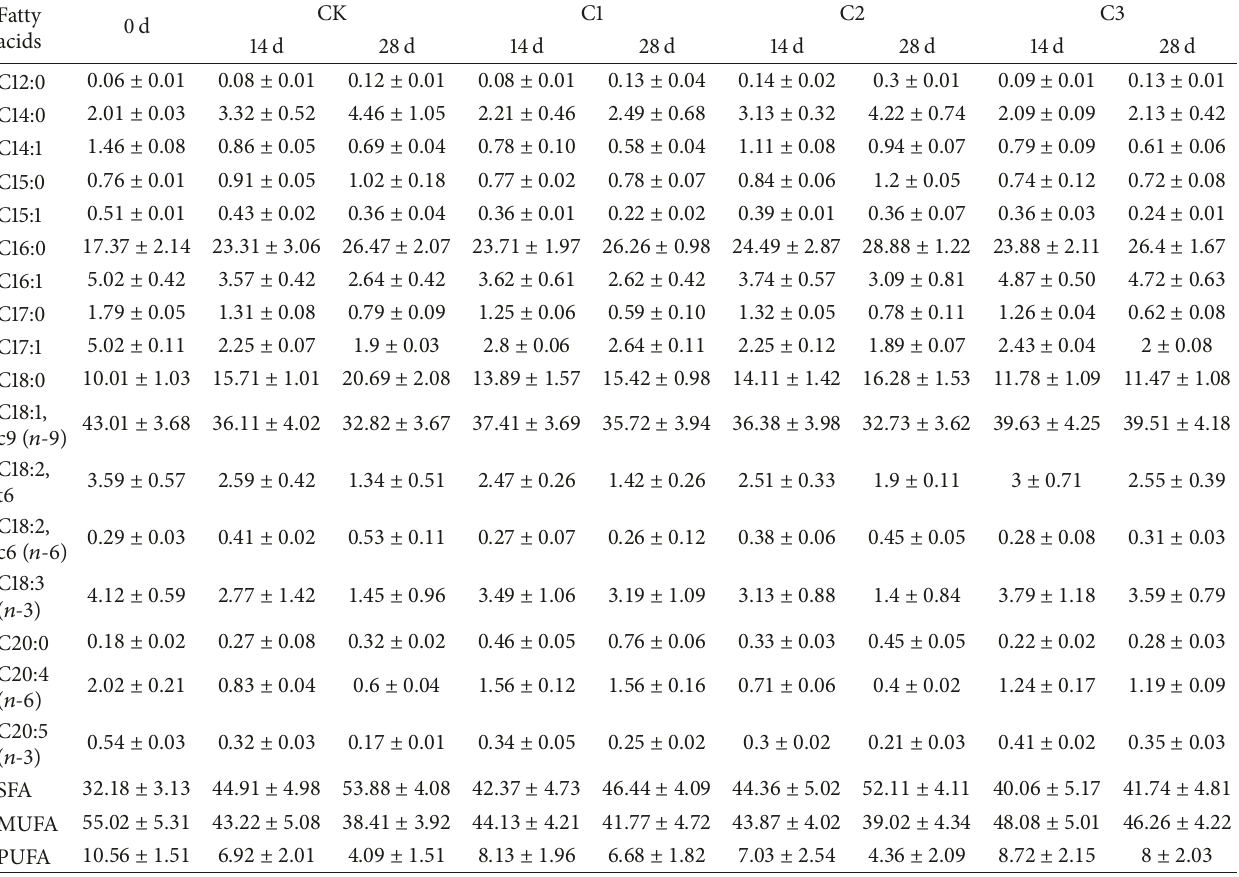
Table 1: Effect of different treatments on fatty acid profile (% of total fatty acids) of the